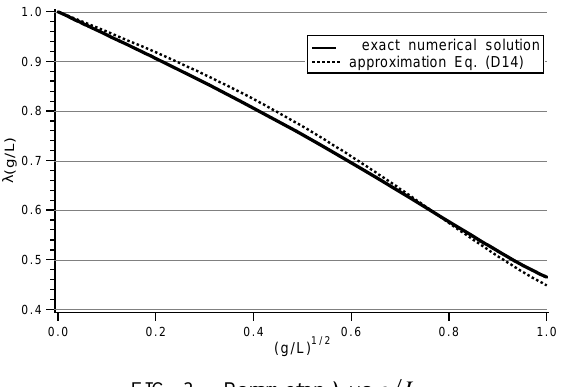
FIG. 3. Parameter l vs g (cid:2) L . FIG. 4. Parameter l for different